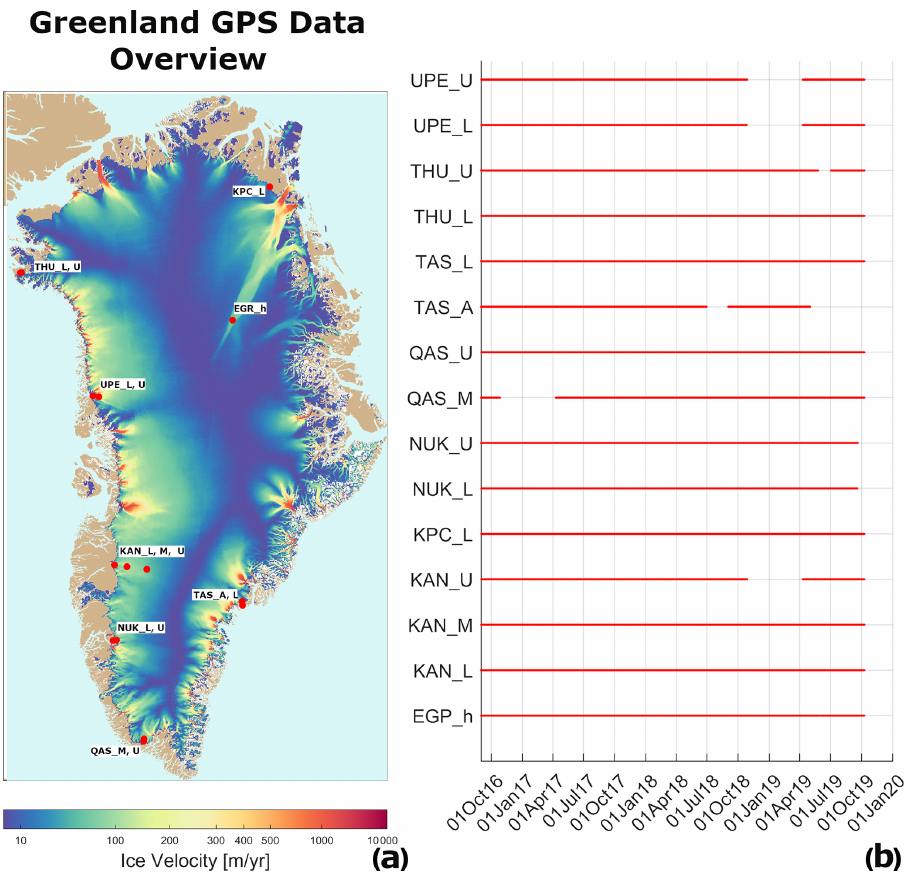
Figure 12. Overview of PROMICE GPS data: (a) locations of the PROMICE GPS stations on the GrIS. The ice velocity mosaic used as the base layer is a 3-year average of all the PROMICE Ice Velocity maps spanning September 2016 to September 2019. (b) List of PROMICE GPS stations used in the validation and their data coverage.